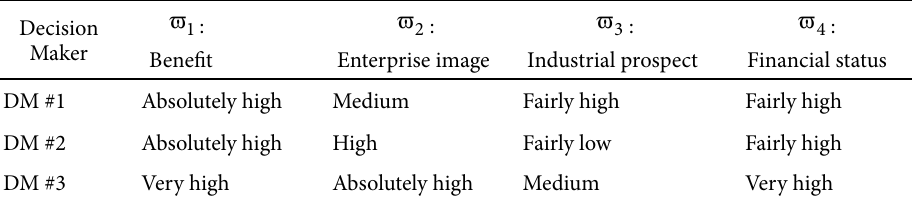
Table 2. Linguistic values of four attributes’ weighting according to decision makers Decision